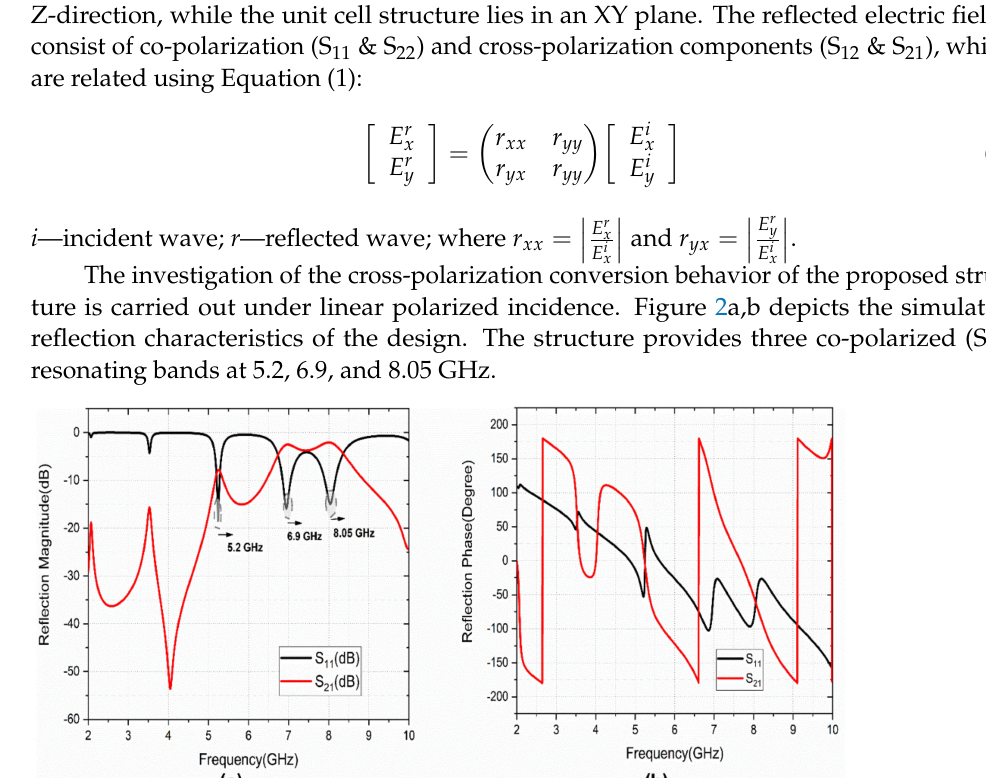
Figure 3a. The role of via in the design is studied with the simulated S 11 (dB), as shown in Figure 3b. It is observed that the resonant frequency is lowered with triple-band operation.